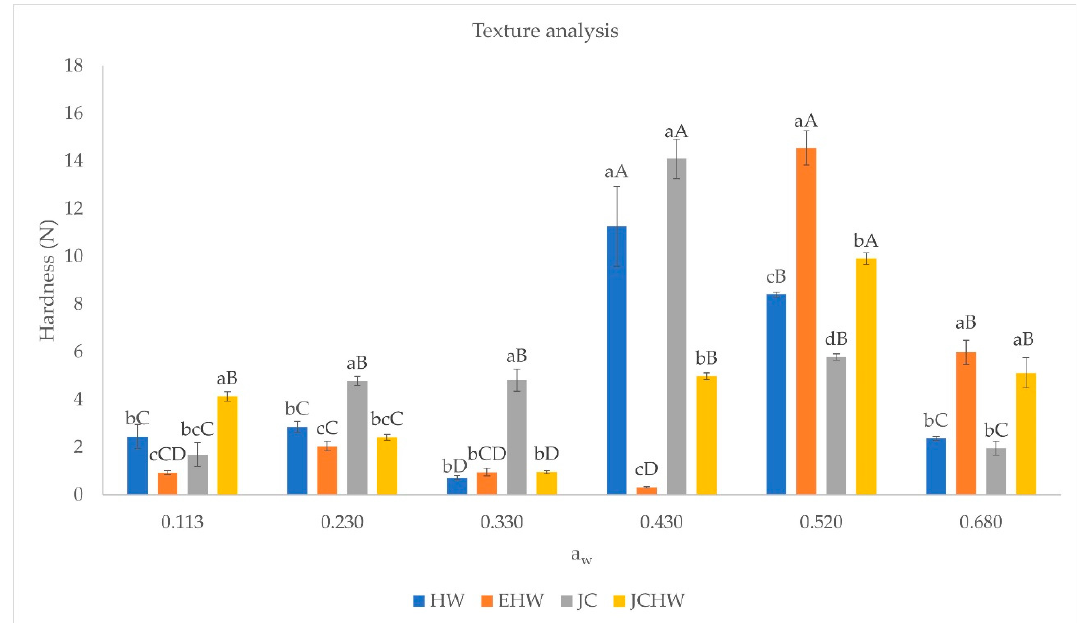
Figure 3. Hardness at different water activities. HW: hot water; EHW: extrusion + hot water; JC: jet cooker; JCHW: jet cooker + hot water. Different small letters for the same a w indicate significant difference according to Tukey test ( p < 0.05) between treatments. Different capital letters in the same treatment indicate significant difference according to Tukey test ( p < 0.05) between water activities.